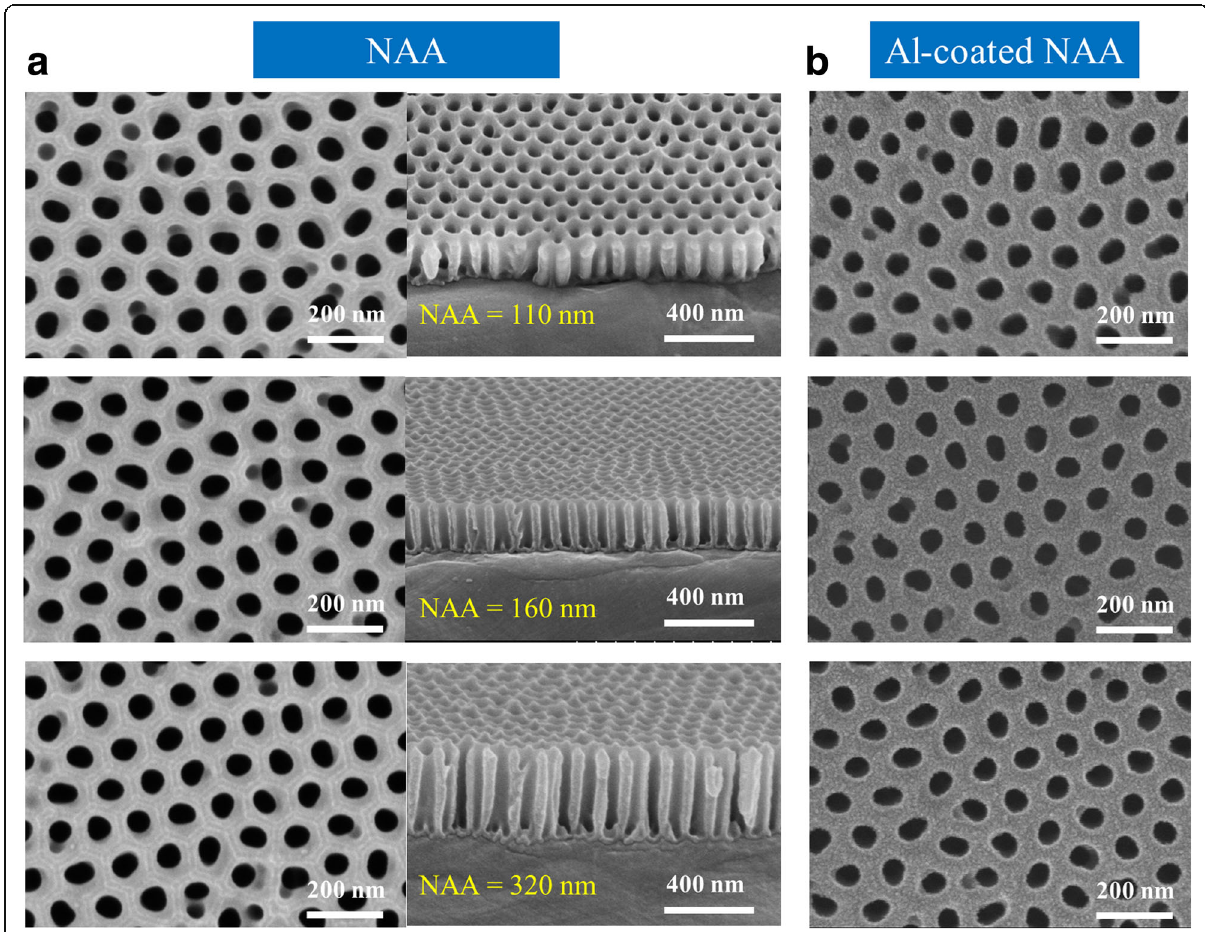
Fig. 4 a Top and cross-sectional views of the SEM images of the manufactured NAA films with different thicknesses of t 2 = 110, 160, and 320 nm, respectively. b Top view of the SEM images of the proposed structure based on Al-coated NAA